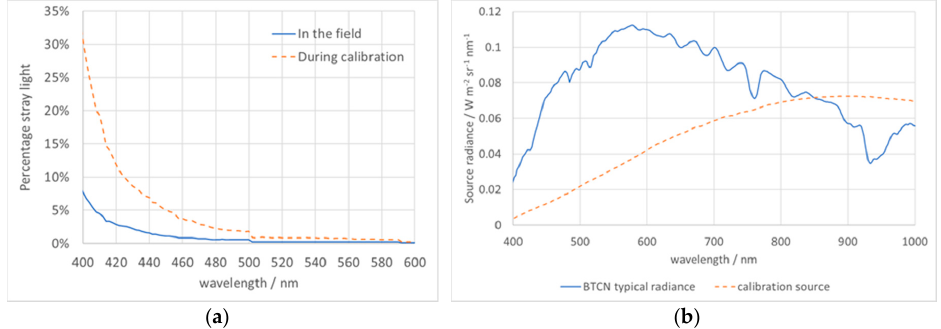
Figure A4. ( a ) Stray light signal as a percentage of the measured signal for both calibration and for a typical in field radiance at BTCN. ( b ) Source radiance levels.